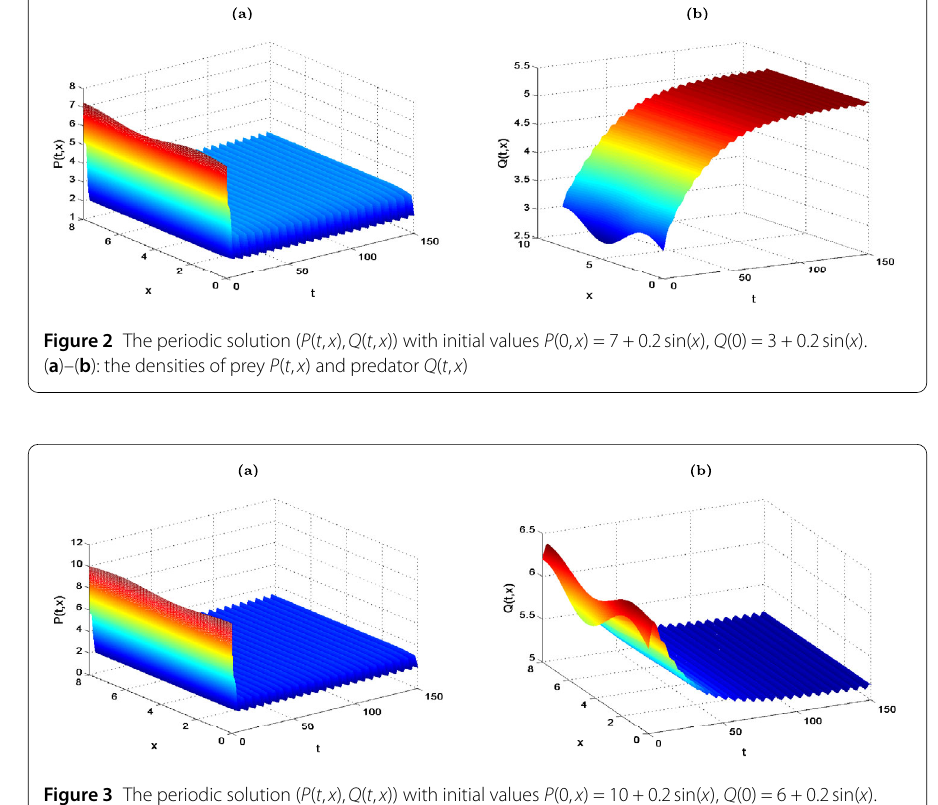
Figure 3 The periodic solution ( P ( t , x ), Q ( t , x )) with initial values P (0, x ) = 10 + 0.2sin( x ), Q (0) = 6 + 0.2sin( x ). ( a )–( b ): the densities of prey P ( t , x ) and predator Q ( t , x